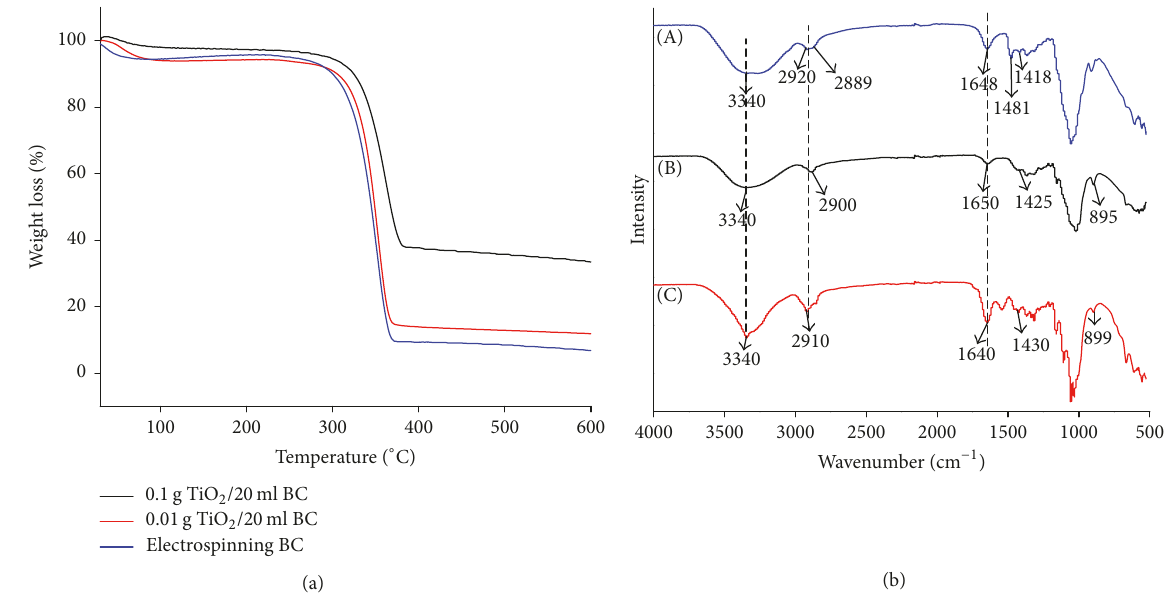
Figure 4: (a) TGA curves of BC and TiO 2 /BC nanofibers; (b) FT-IR spectrum of AAEM, TiO 2 /BC hybrid fibers, and native BC.